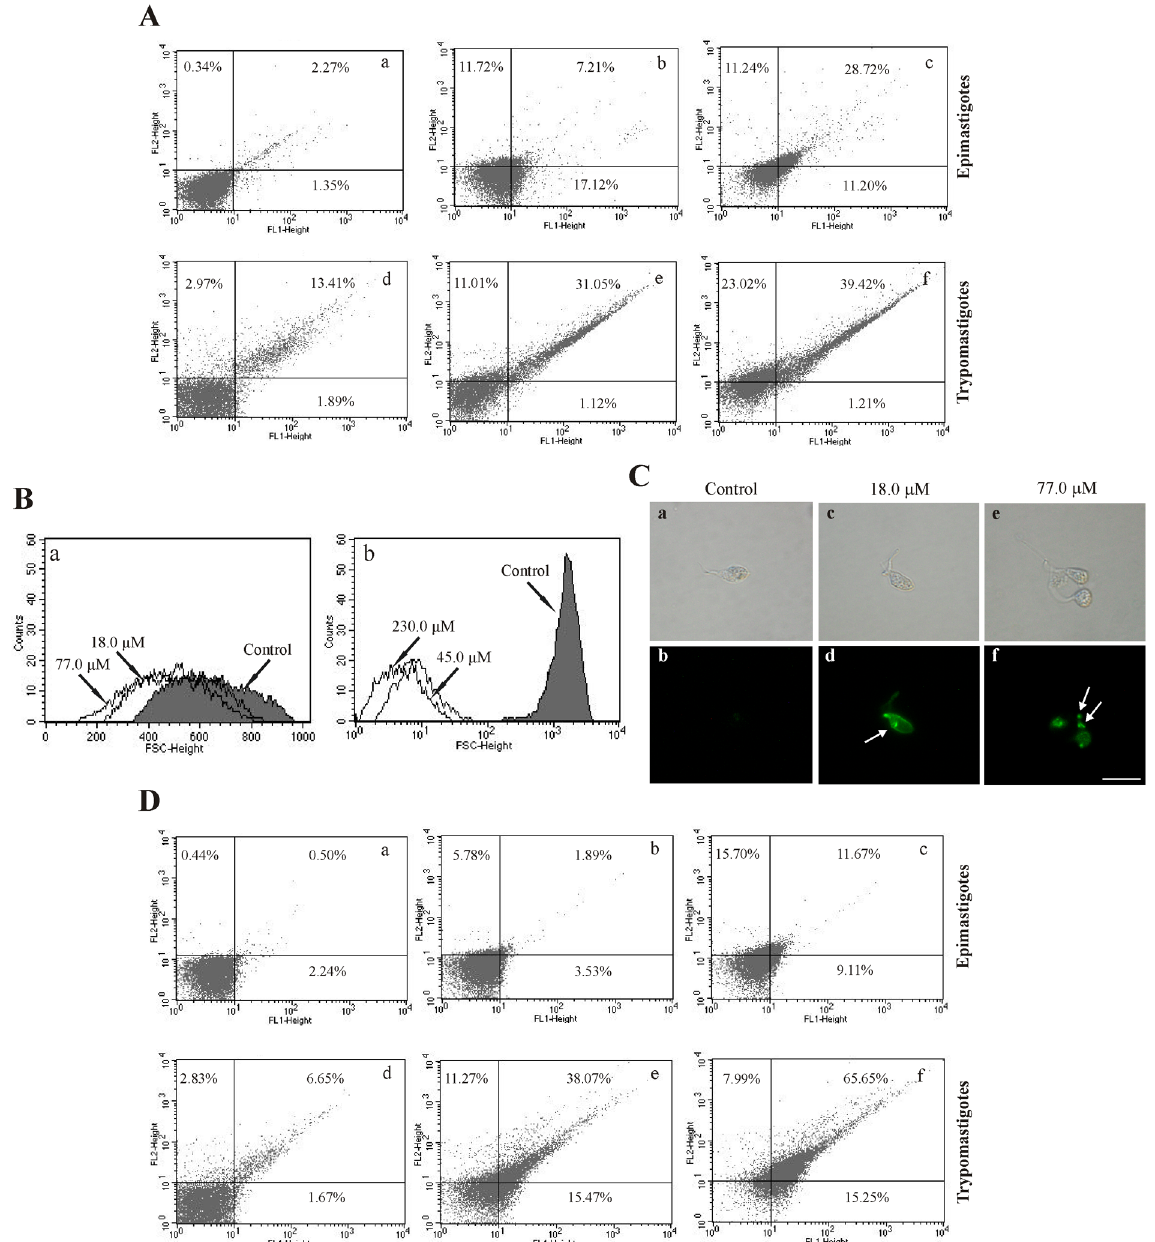
Fig 3. Evaluation of phosphatidylserine exposure, cell volume, DNA fragmentation and cell membrane integrity in T . cruzi treated with C4. (A) Phosphatidylserine exposure in epimastigote and trypomastigote forms of T . cruzi treated with C4 for 3 h and stained with the fluorescence probes annexin V-FITC and PI. (a) Untreated epimastigote. (b, c) Epimastigotes treated with 18.0 and 77.0 μ M of C4 . (d) Untreated trypomastigotes. (e, f) Trypomastigotes treated with 45.0 and 230 μ M of C4 . (B) Reduction of cell volume of T . cruzi treated with C4 for 3 h and analyzed by flow cytometry. (a) Epimastigote forms. (b) Trypomastigote forms. Forward light scatter (FSC-H) was considered to represent cell volume. Arrows correspond to the concentrations tested. The control group (untreated parasites) is also shown. (C) DNA fragmentation in epimastigote forms of T . cruzi treated with C4 for 24 h and stained with TUNEL. The gray column indicates differential interference contrast, and the black column indicates fluorescence. (a-b) Untreated epimastigotes. (c, d) Epimastigotes treated with 18.0 μ M. (e, f) Epimastigotes treated with 77.0 μ M. Green fluorescence indicates DNA fragmentation. Scale bars = 10 μ m. (D) Alteration of the cell membrane in epimastigote and trypomastigote forms of T . cruzi treated with C4 for 3 h and stained with the fluorescence probe PI. (a) Untreated epimastigotes. (b, c) Epimastigotes treated with 18.0 and 77.0 μ M of C4 . (d) Untreated trypomastigotes. (e, f) Trypomastigotes treated with 45.0 and 230.0 μ M of C4 . The numbers show the percentage of PI-positive cells in the upper right and left quadrants.